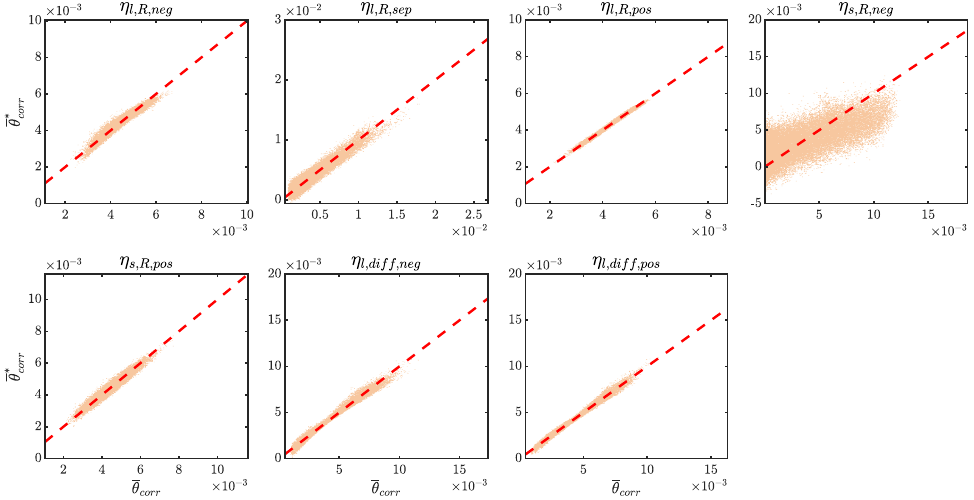
Figure 9. Results of parameter correlation for case 4. A correlation relation can be observed for each process except for the solid conduction in the